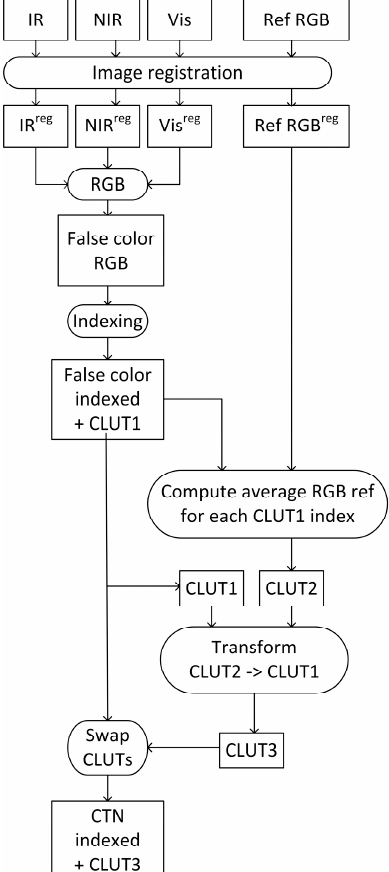
Figure 5. Processing scheme of the luminance-from-fit (LFF) and R3DF sample based color fusion methods.